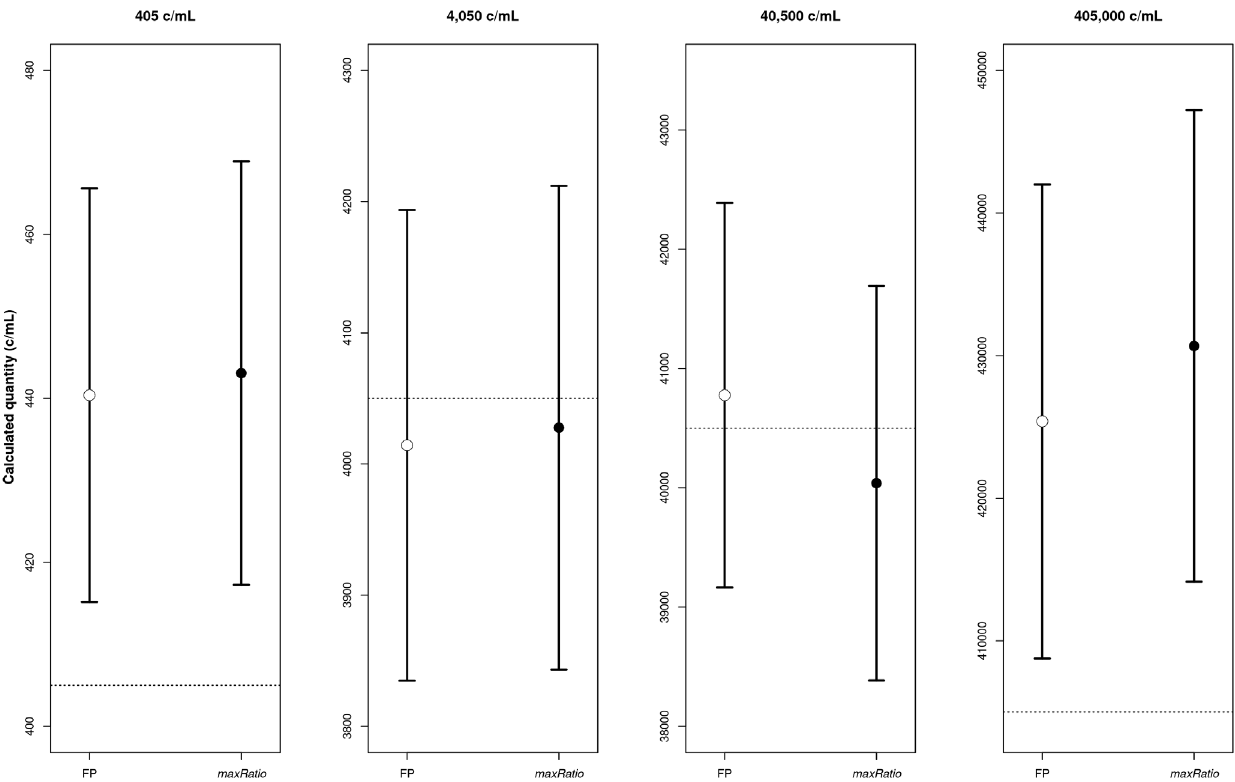
Figure 3. CD quantification. The four panels represent the calculated copy numbers obtained using FP ( ○ ) or maxRatio ( ● ) for each dilution. The dots and bars represent the mean and the 95% CI of the data, respectively.